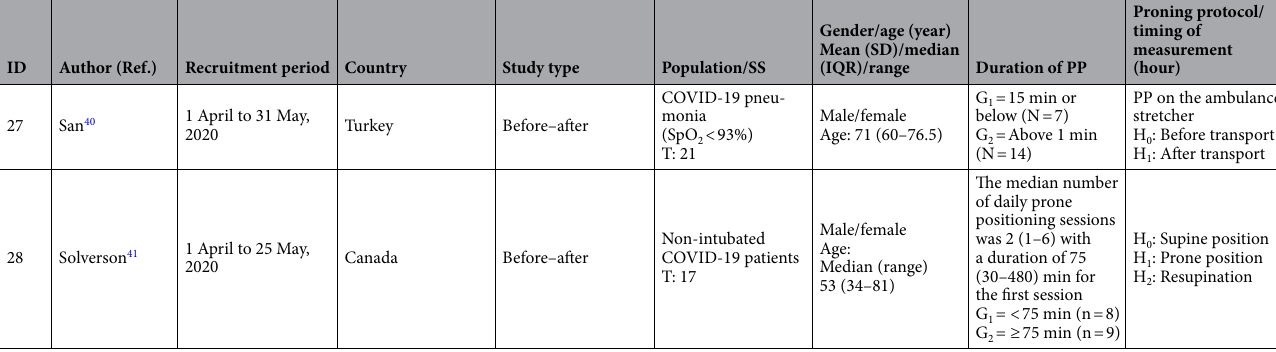
Fig. 3. It should be noted that prone position leads to improvement of PaO 2 but does not have any effects on the respiratory rate in general, especially in the quasi-experimental design. The pooled estimate and 95% CI for death rate and intubation rate were 19.03 (8.19–32.61) and 30.68 (21.39–40.75); respectively (Fig. 4). Figure 5 showed PMD of respiratory parameters based on ventilation status. PMD of Spo 2 (Sao 2 ) in Intubation and Non-intubation subgroup was 10.56 (95% CI − 18.15 to 39.26) and 8.57 (95% CI 3.47–13.67); respectively. This means that the prone position in COVID-19 patients with non-intubation leads to significant improve- ment corresponding to Spo 2 (Sao 2 ) but Intubation have no effects on Spo 2 (Sao 2 ) improvement. Also PMD of PaO 2 /FIO 2 in Intubation and non-intubation subgroup was 65.03 (95% CI 6.06–123.99) and 49.56 (95% CI 26.56–72.56); respectively. This means that the prone position in COVID-19 patients leads to significant improve- ment of PaO 2 /FIO 2 Ratio, but this value for Intubated patients was higher than non-intubated groups. Situation of other parameter was showed in Fig. 5. Publication bias. Based on Egger’s test results, significant publication bias was observed for PaO Ratio (Coefficient: 5.63; 95% CI 0.91–10.35; p: 0.024). Therefore, the fill- and trim-adjusted PaO 2 /FIO 2 Ratio